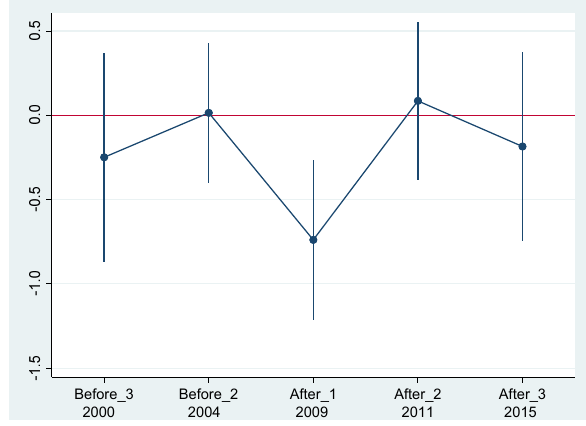
Figure 1. Parallel trend test results.